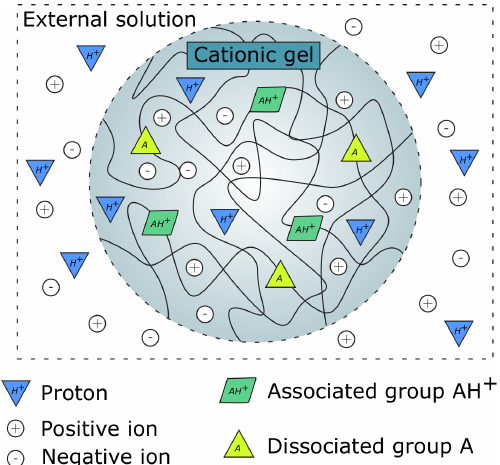
Figure 7. Illustration of a cationic gel in an external